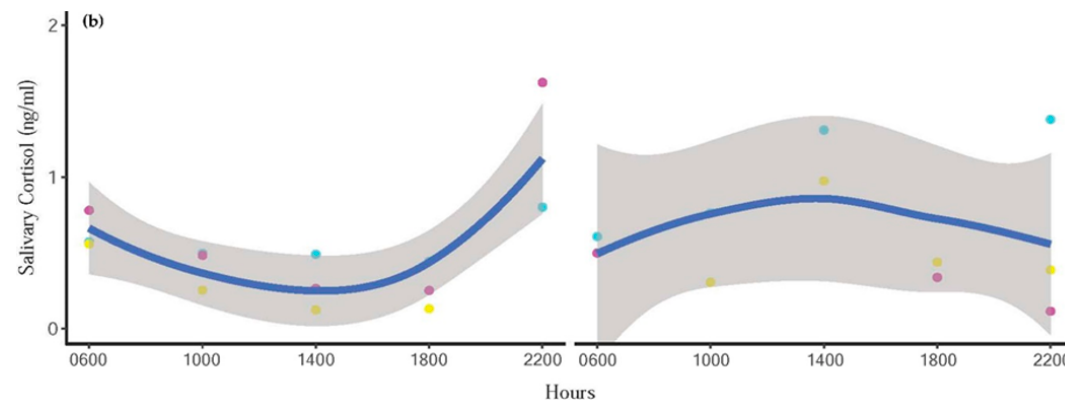
( b ) Figure 5. Representative profiles of diurnal ( a ) IgA and ( b ) cortisol trends in one male (left) and one female (right) elephant that did not follow the typical or expected pattern. Blue line represents the trend line, and the shaded area is a 95% confidence interval of the mean. Day 1 = red points, Day 2 = blue points, and Day 3 = yellow